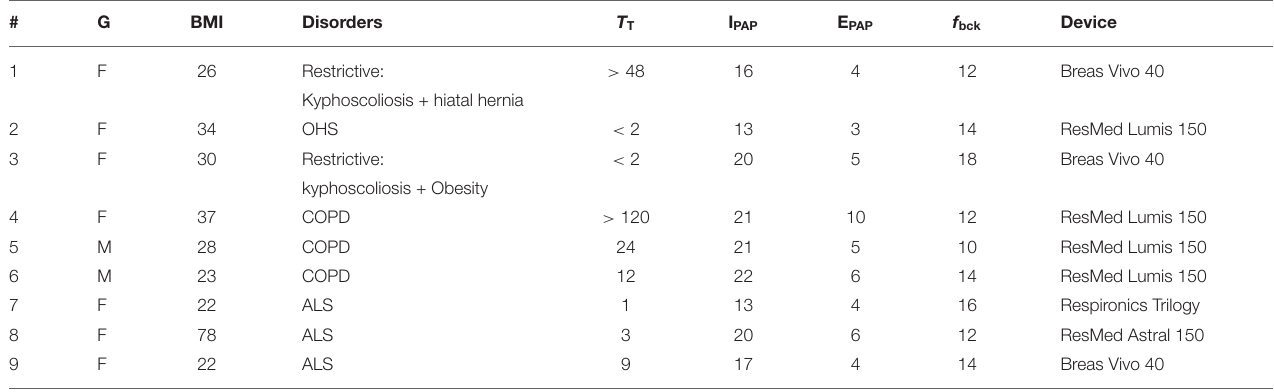
TABLE 1 | Patient